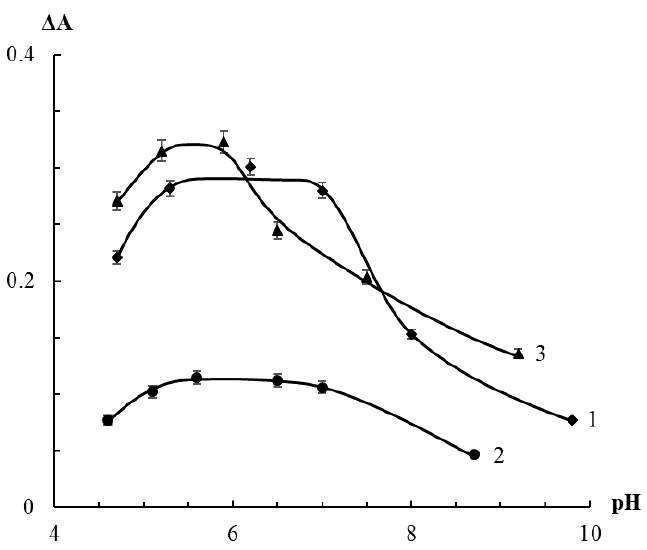
Figure 4. Change in the absorbance of AgTNPs solutions in the presence of hydrogen peroxide (1), tert -butyl hydroperoxide (2) and peracetic acid (3) depending on pH. c (AgTNPs) = 0.16 mM Ag; (1) c (HP) = 50 µ M, t = 10 min; (2) c (TBHP) = 300 µ M, t = 20 min; (3) c (PAA) = 3 µ M, t = 15 min.